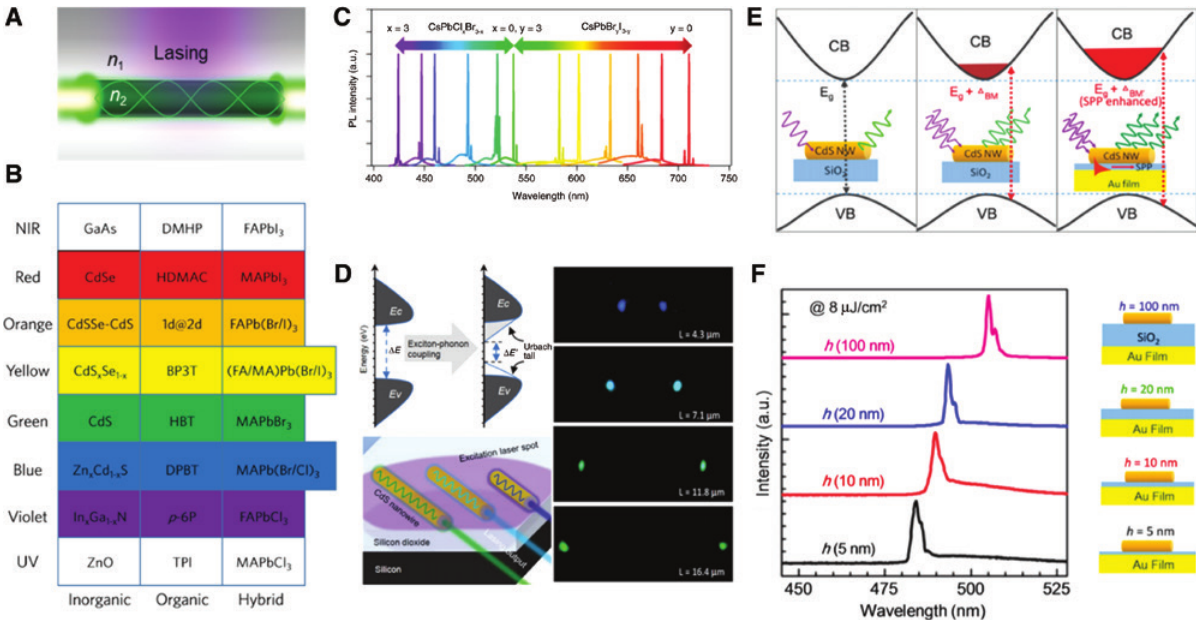
Figure 1: Semiconductor nanowire lasers. (A) Schematic of semiconductor NW laser. (B) Colorful lasing from UV to NIR in inorganic, organic, and hybrid semiconductor NWs. (C) Broad wavelength-tunable lasing from single-crystal perovskite NWs covering the visible region. Reproduced with permission [72]. Copyright 2016, American Chemical Society. (D) Left: schematic of the Urbach tails at the band edges caused by electron-phonon coupling and various output lasing colors in CdS NW/SiO /Si device. Right: optical images of four individual CdS NW lasers with different lengths and 2 colors owing to self-absorption. Reproduced with permission [73]. Copyright 2013, American Chemical Society. (E) Schematic of the three effects on the bandgap energy of undoped semiconductor NWs: without the BM effect, with the BM effect, and the SPP-enhanced BM effect. (F) The lasing peaks of four devices and their illustrations under the same pump fluence. Reproduced with permission [74]. Copyright 2013, American Chemical